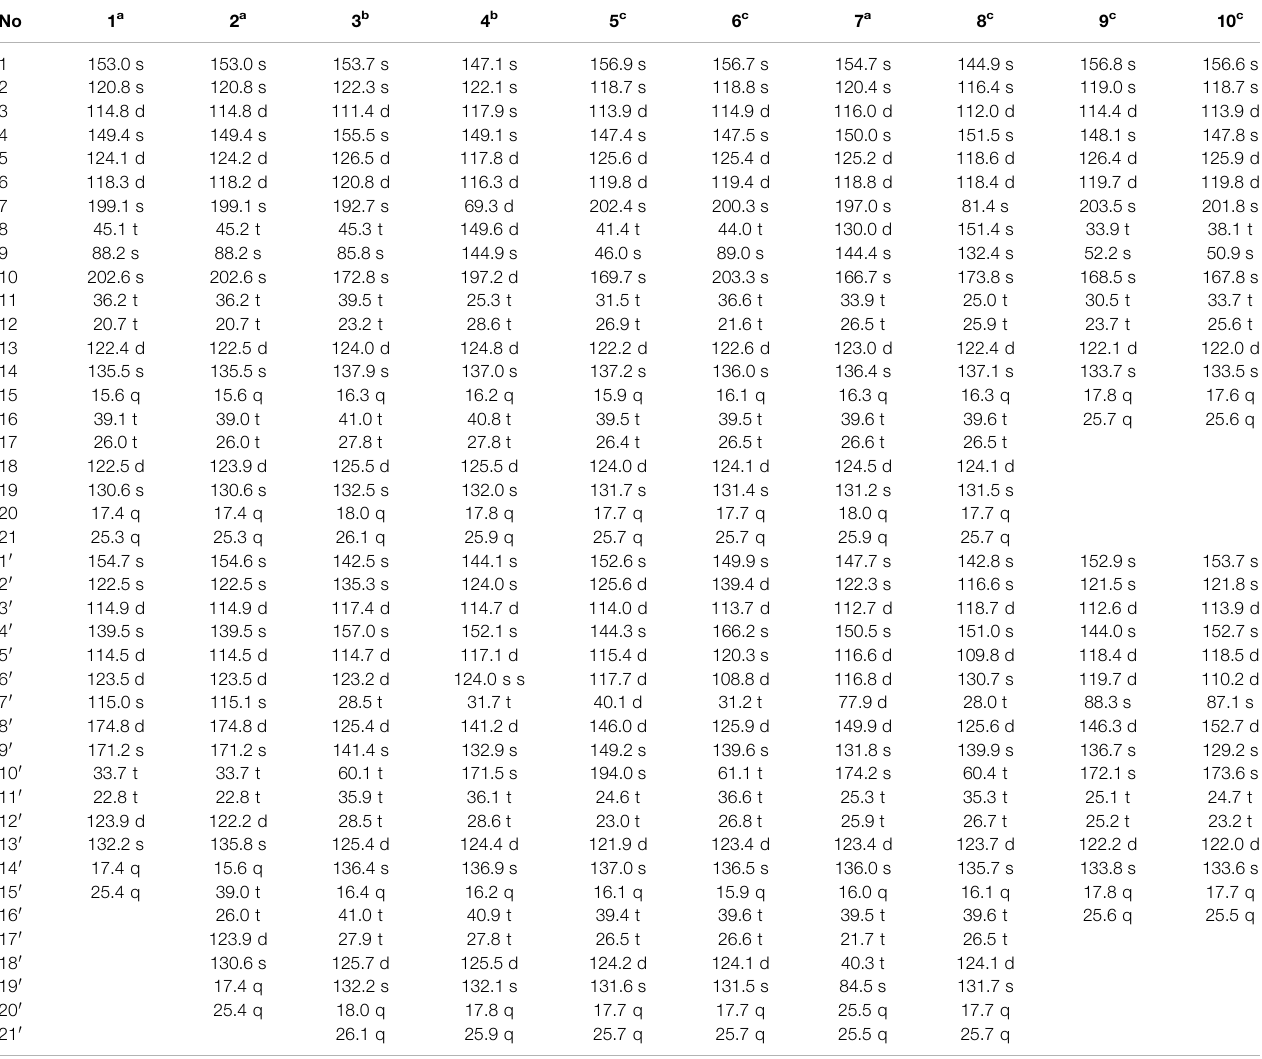
TABLE 2 | 13 C NMR data of 1 – 10 ( δ in ppm, J in